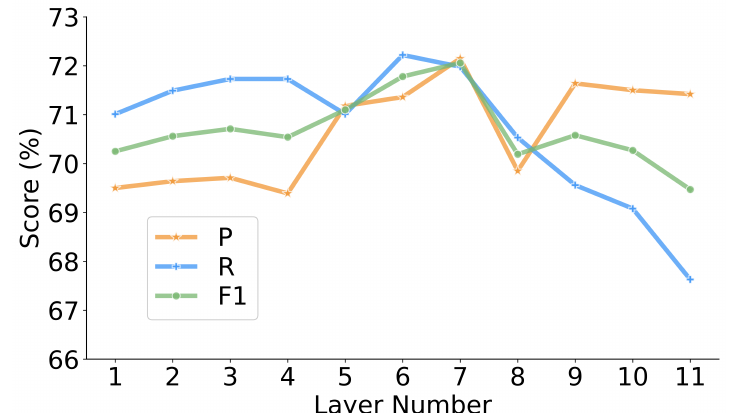
Figure 4. Results of PWII-BERT and WIIA are applied at different